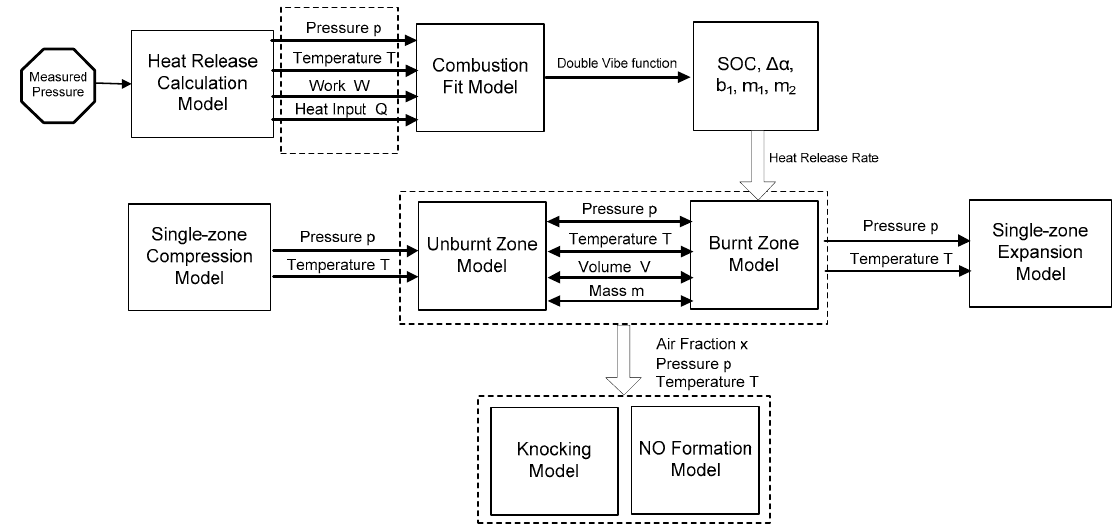
Figure 5. Calculation flow of in-cylinder model.